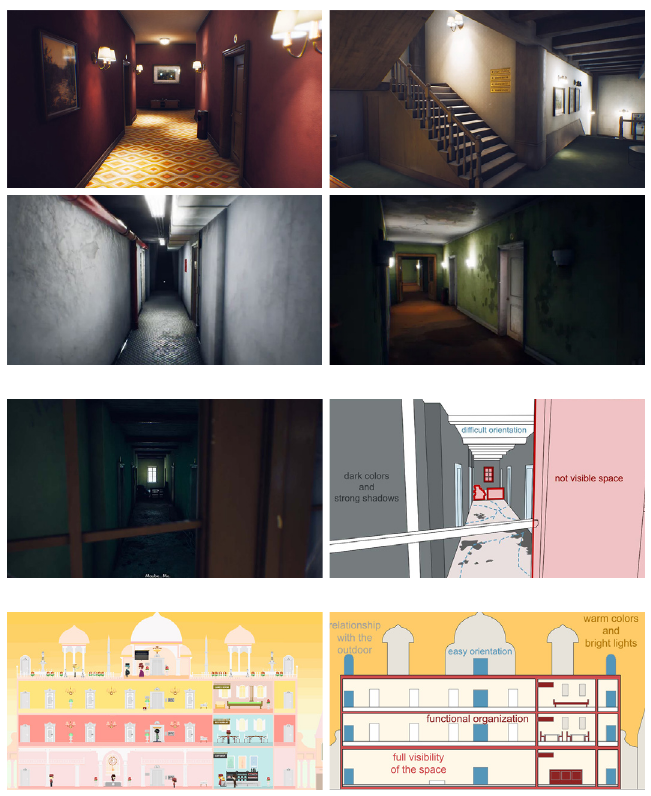
Fig. 1 One-O-One Games Studio,